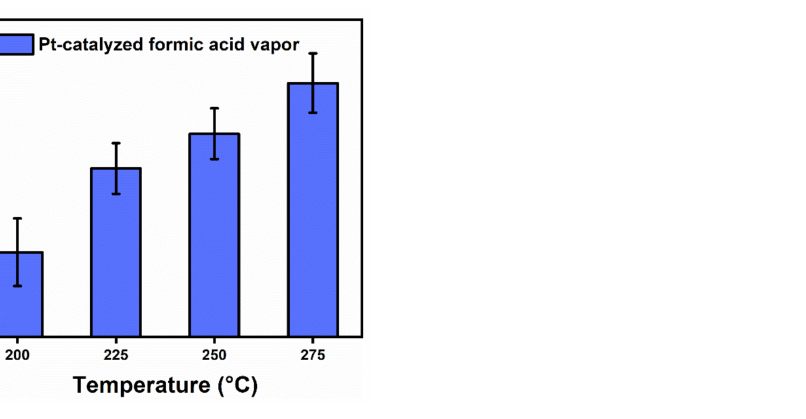
Figure 12. The shear strength of SiC/Cu–Cu substrates sintered at different temperatures for 30 min in Pt-catalyzed formic acid vapor.